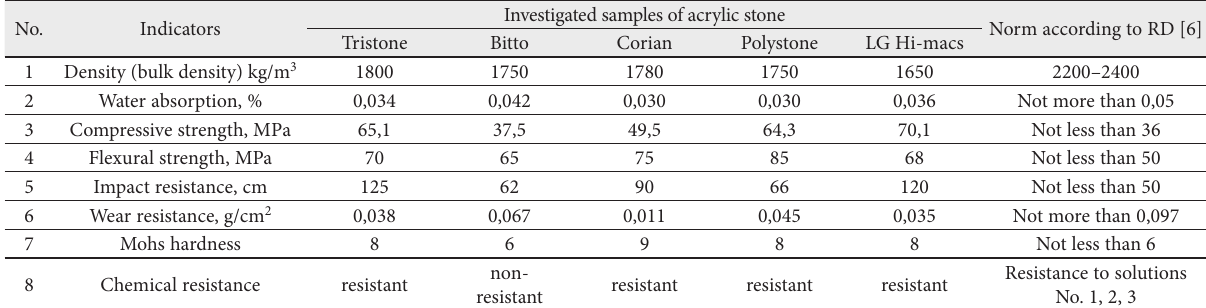
Indicators of consumer properties of samples of acrylic artificial stone of different